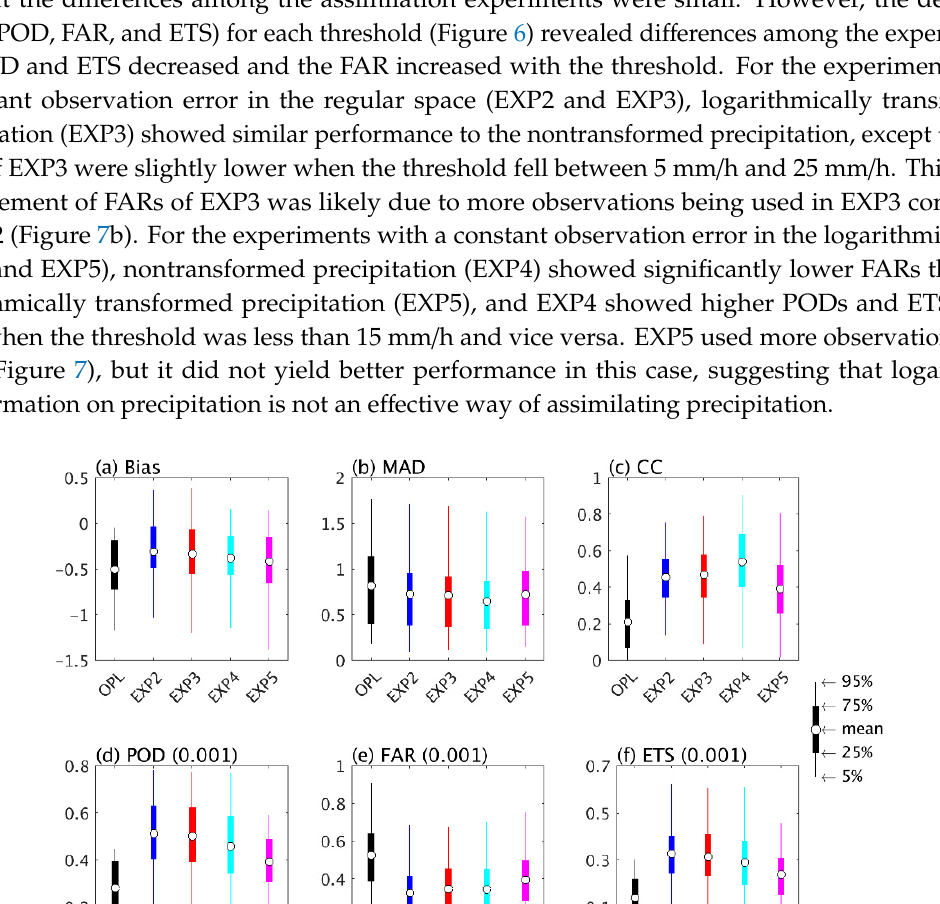
Figure 6. Detection scores of hourly precipitation estimated from assimilation experiments and the OPL experiment at different thresholds ranging from 1 mm/hr to 30 mm/hr. EXP2 and EXP3 represent experiments with nontransformed and logarithmically transformed precipitation with constant observation error, respectively; EXP4 and EXP5 are as for EXP2 and EXP3, but with increasing observation error with precipitation magnitude.